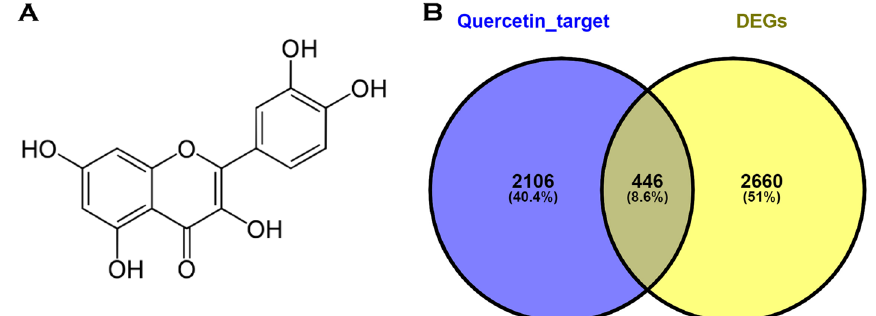
Fig. 1 A The chemical structure of Quercetin. B A Venn diagram showing the overlapping genes between quercetin targets and the DEGs. The left and right circles depict the number of genes that are unique to both quercetin targets and the DEGs respectively while the intersection of the circles depicts the genes that are found in both